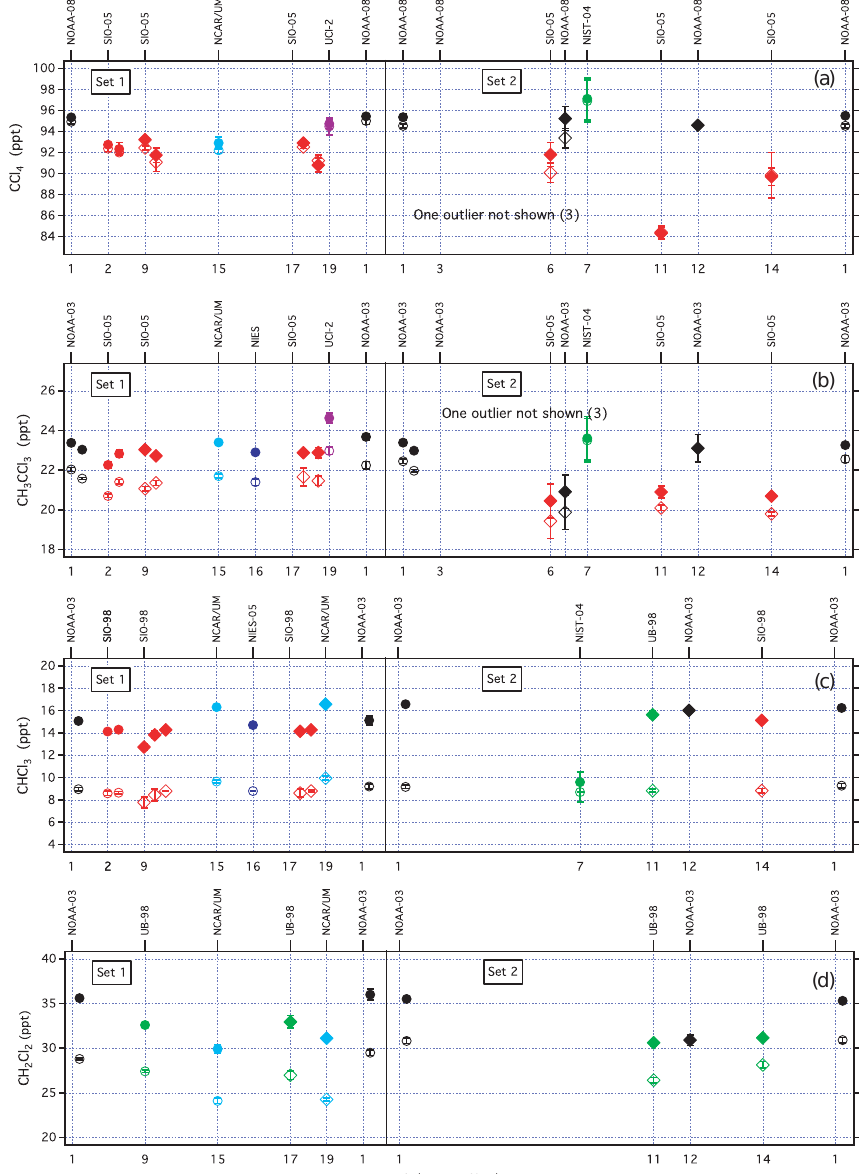
Fig. 2. Same as Fig. 1 for trace gases (a) CCl 4 , (b) CH 3 CCl 3 , (c) CHCl 3 , (d) CH 2 Cl 2